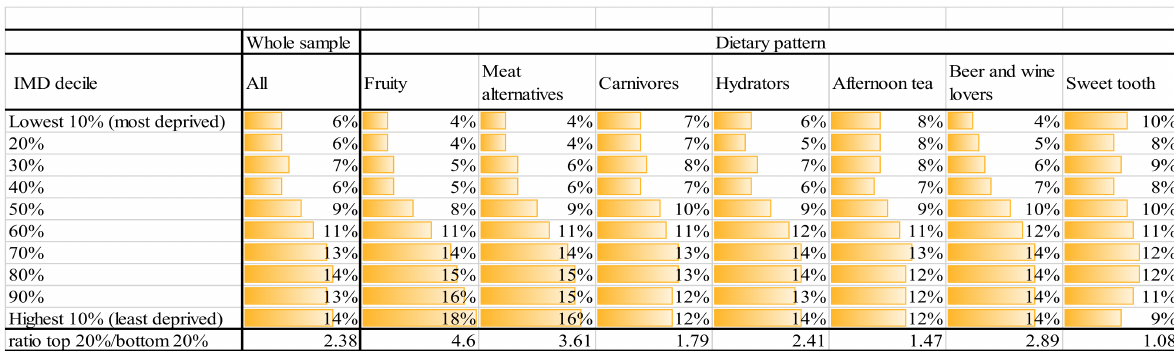
Figure 4. Distribution of groups of loyalty card holders amongst Index of Multiple Deprivation (IMD) deciles.